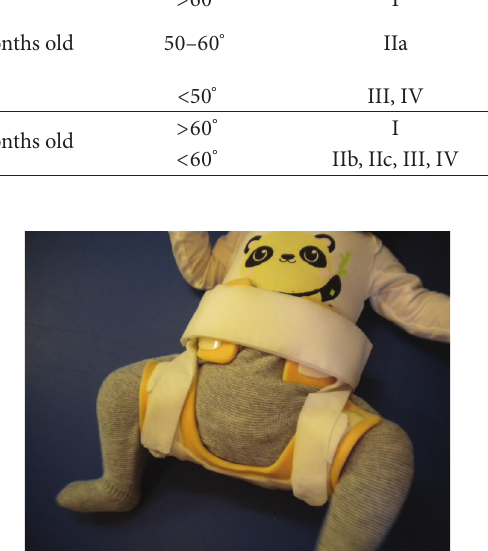
Figure 2: Brace on the child, view from front.